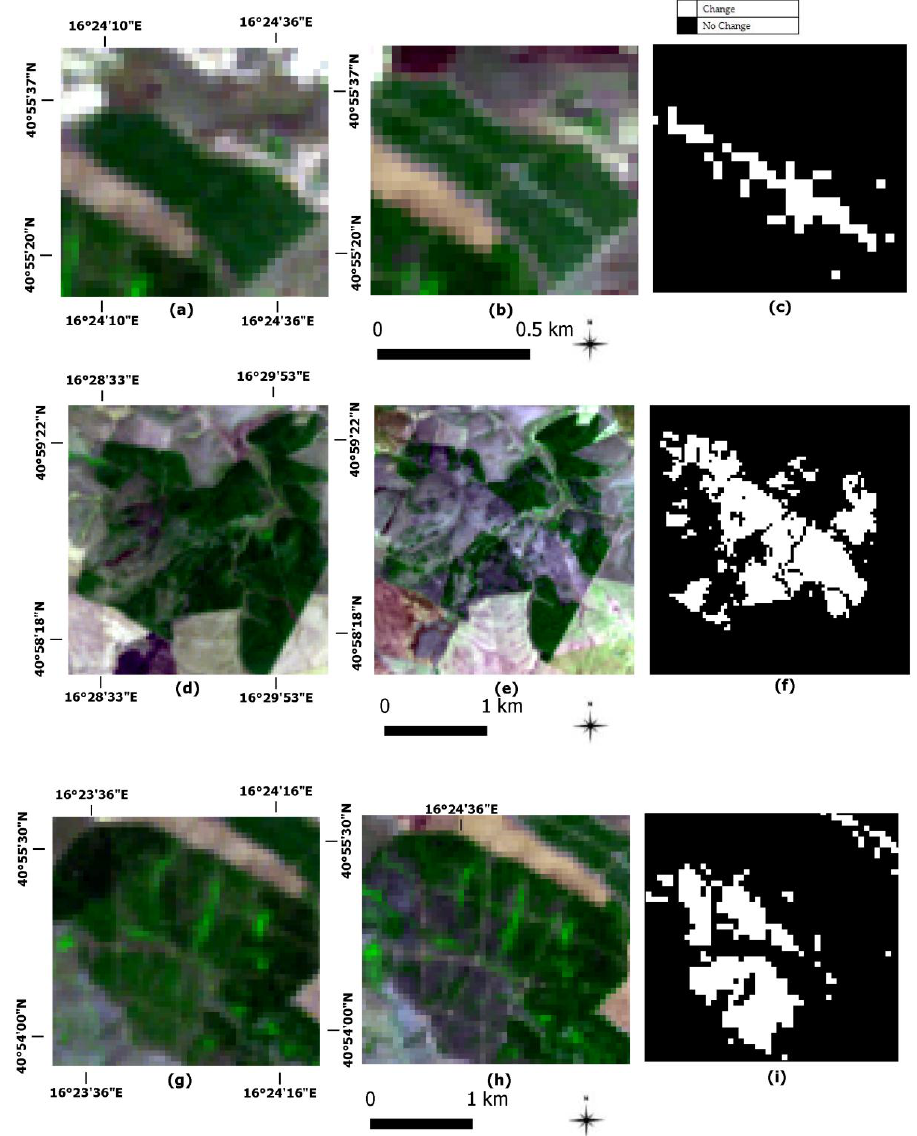
Figure 4 Figure 4. Experiment 1—DIFF_NDVI_HR close-up area from Figure 3, Italian site: ( a – c ) close-ups